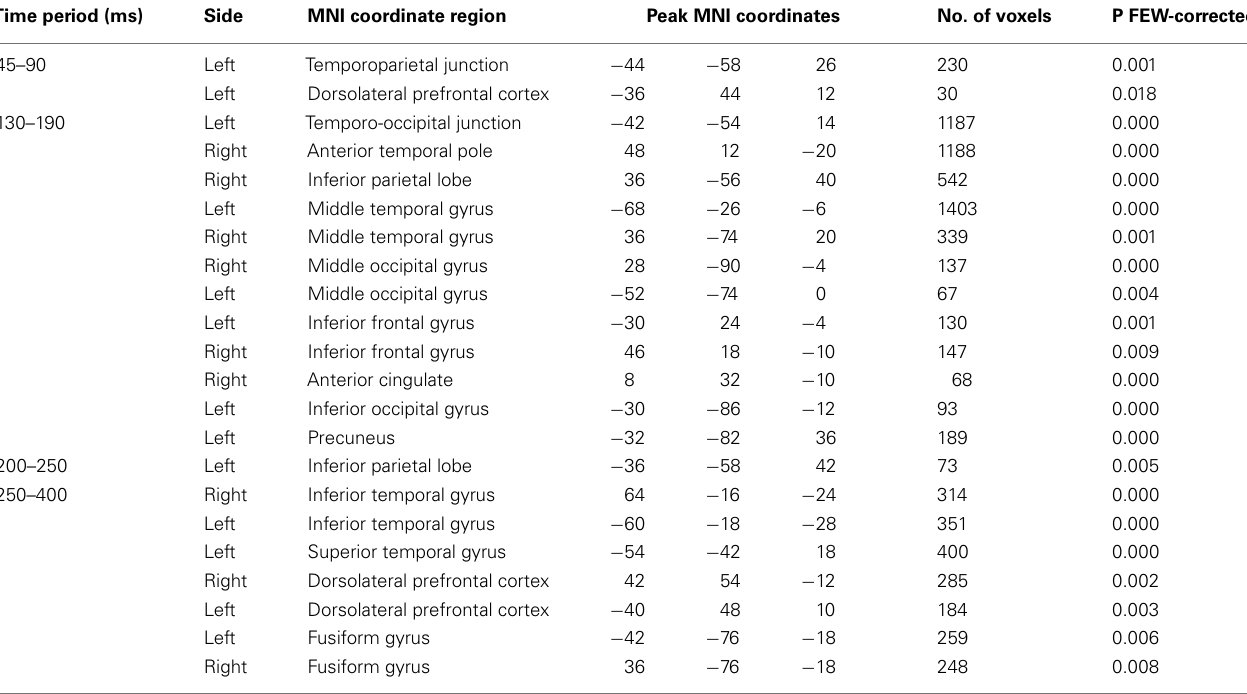
Table 1 | Results of the full factorial source reconstruction analysis for each of the four time windows investigated. Time period